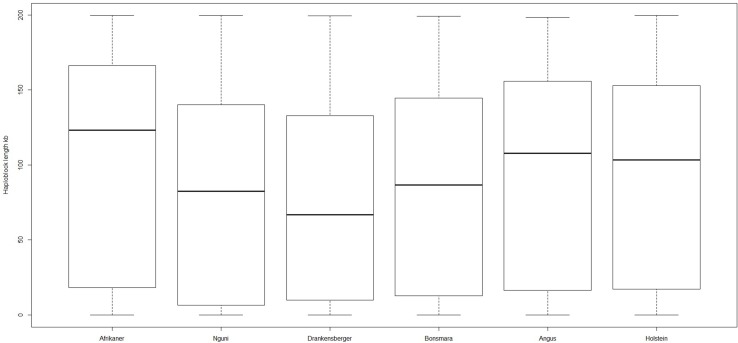
Box plot of haploblock size in different breeds.